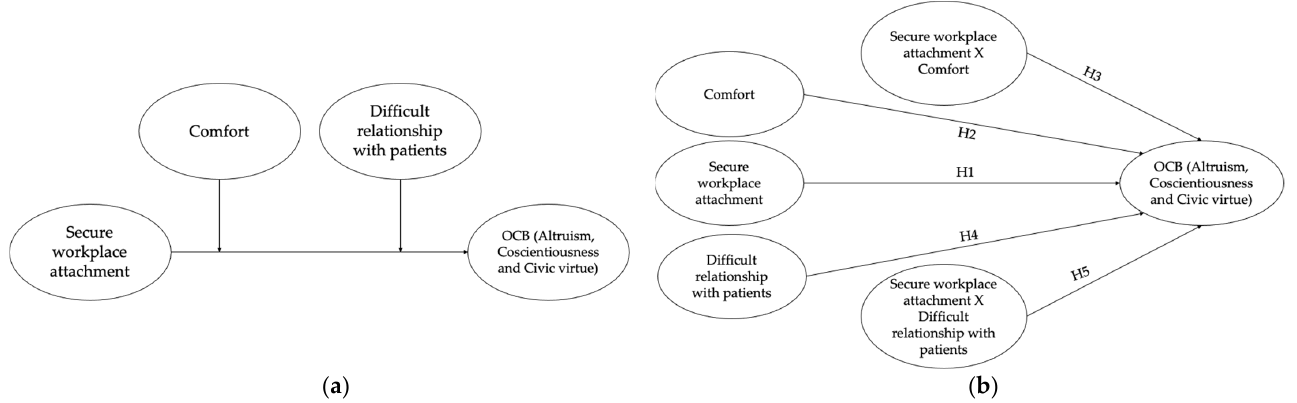
Figure 1. ( a ) Conceptual model of the tested model. ( b ) Diagram of the tested model.